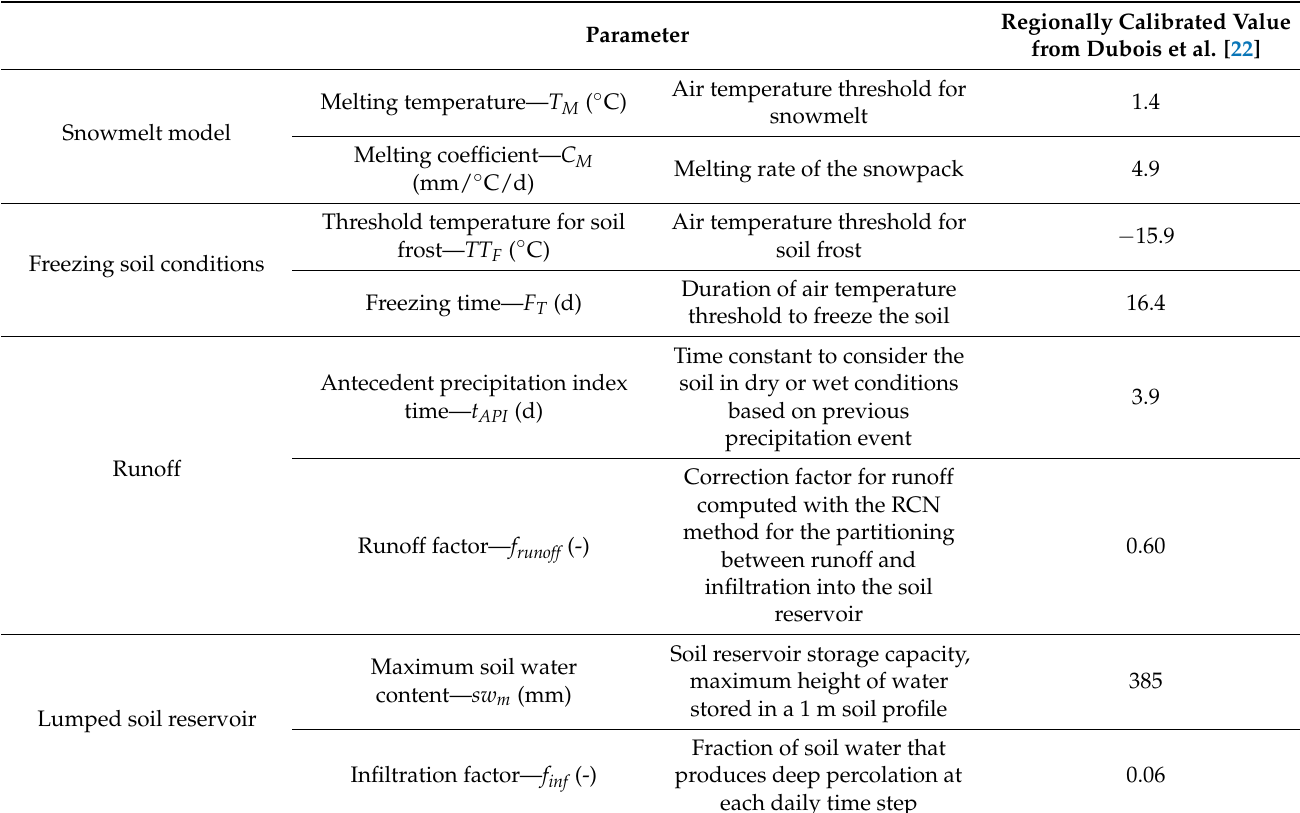
Table 2. Description of the HydroBudget parameters and calibrated values from Dubois et al. [22]. Parameter